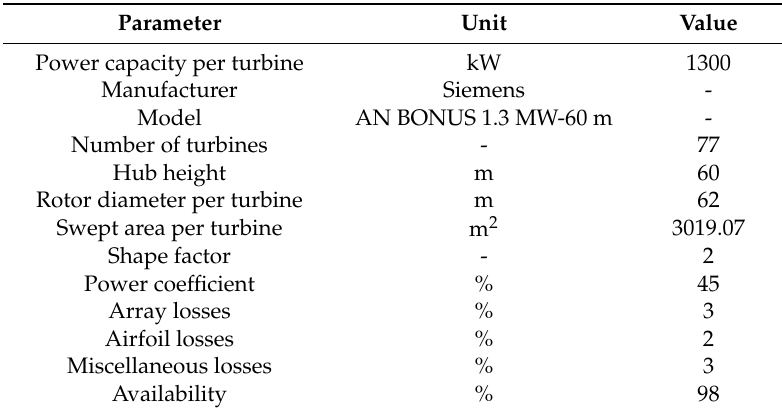
Table 2. Specifications of wind